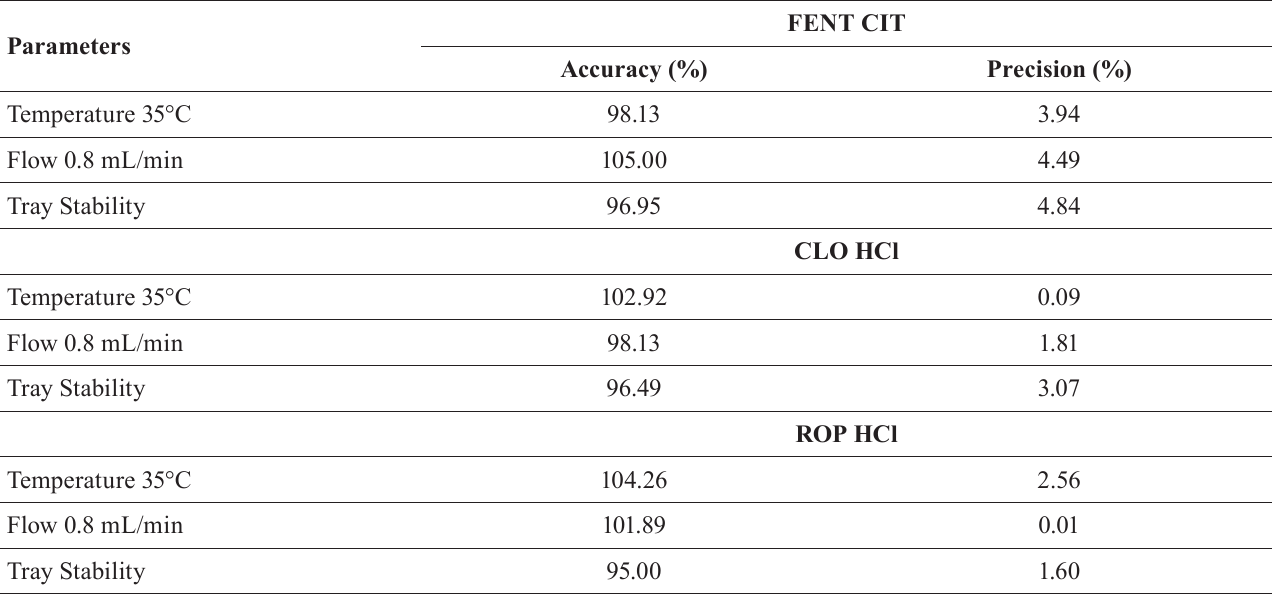
TABLE IV - Short term robustness and stability test results